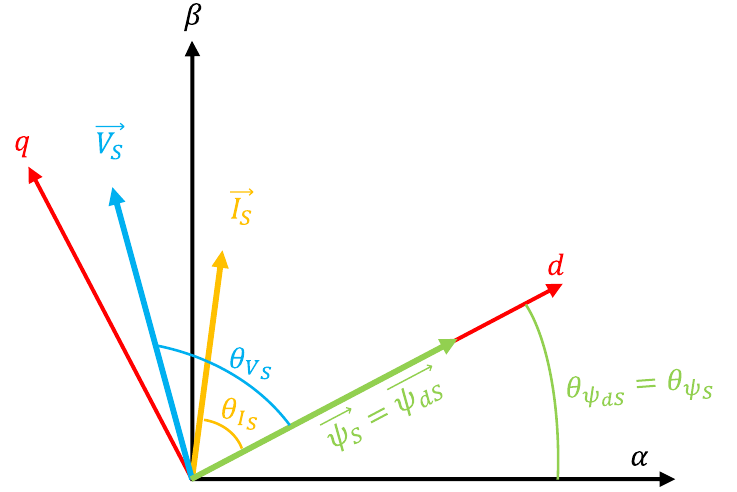
Figure 8. Stator flux ideally aligned with d -axis.